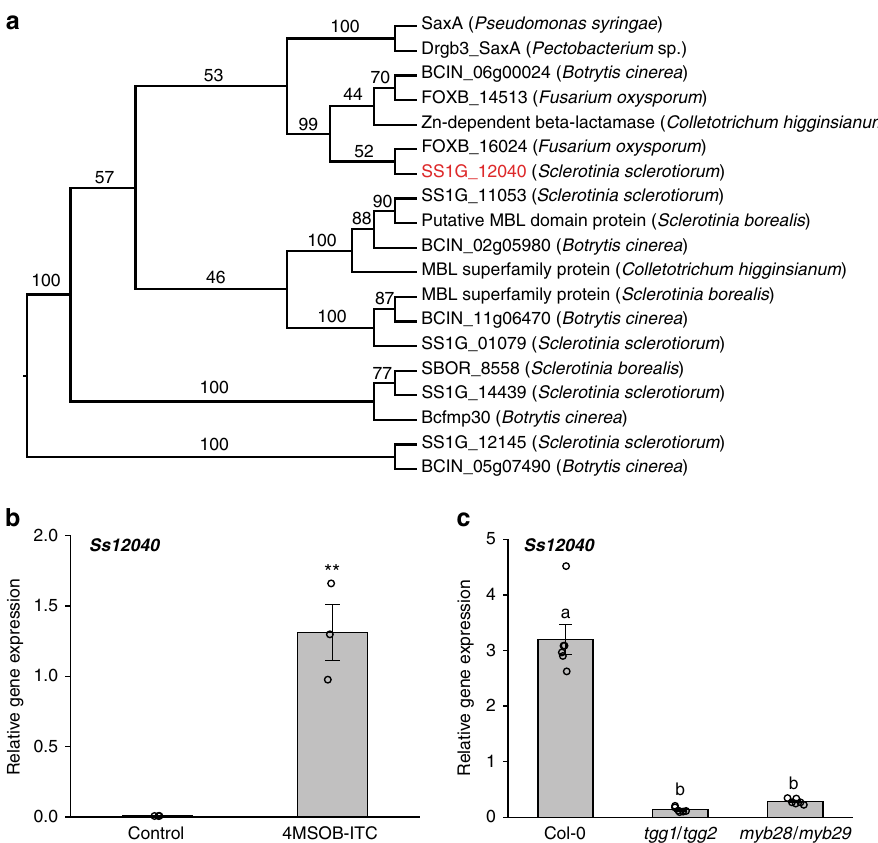
Fig. 3 Ss12040 is a SaxA candidate gene in S. sclerotiorum . a Maximum likelihood tree of fungal metallo- β -lactamase-like enzymes with similarity to known bacterial ITCases. Amino acid sequences were aligned with MEGA, and phylogenetic trees were constructed with PhyML using 1000 bootstraps. Numbers on each branch in the ML tree signify bootstrap values. b Induction of SaxA candidate gene Ss12040 expression by 4MSOB-ITC in vitro. The fungal culture medium was supplemented with 4MSOB-ITC (25 µ M), with only ethanol being added to the control medium. Gene expression was determined 30 min post inoculation. Data represent mean ± SEM ( n = 3 independent fungal cultures; in vitro induction of Ss12040 by 4MSOB-ITC was repeated once) and were analyzed by a two-tailed Student ’ s t test (** p < 0.01). c Expression of SaxA candidate gene Ss12040 24 hpi of different A. thaliana lines. Data represent mean ± SEM ( n = 6 independent inoculated plants) and were analyzed by a Kruskal – Wallis rank sum test ( p < 0.001) followed by a Games – Howell post-hoc test. Different letters above the bars indicate signi fi cant differences at p < 0.05. 4MSOB-ITC, 4-methylsul fi nylbutyl isothiocyanate. Source data are provided as a Source data fi le.